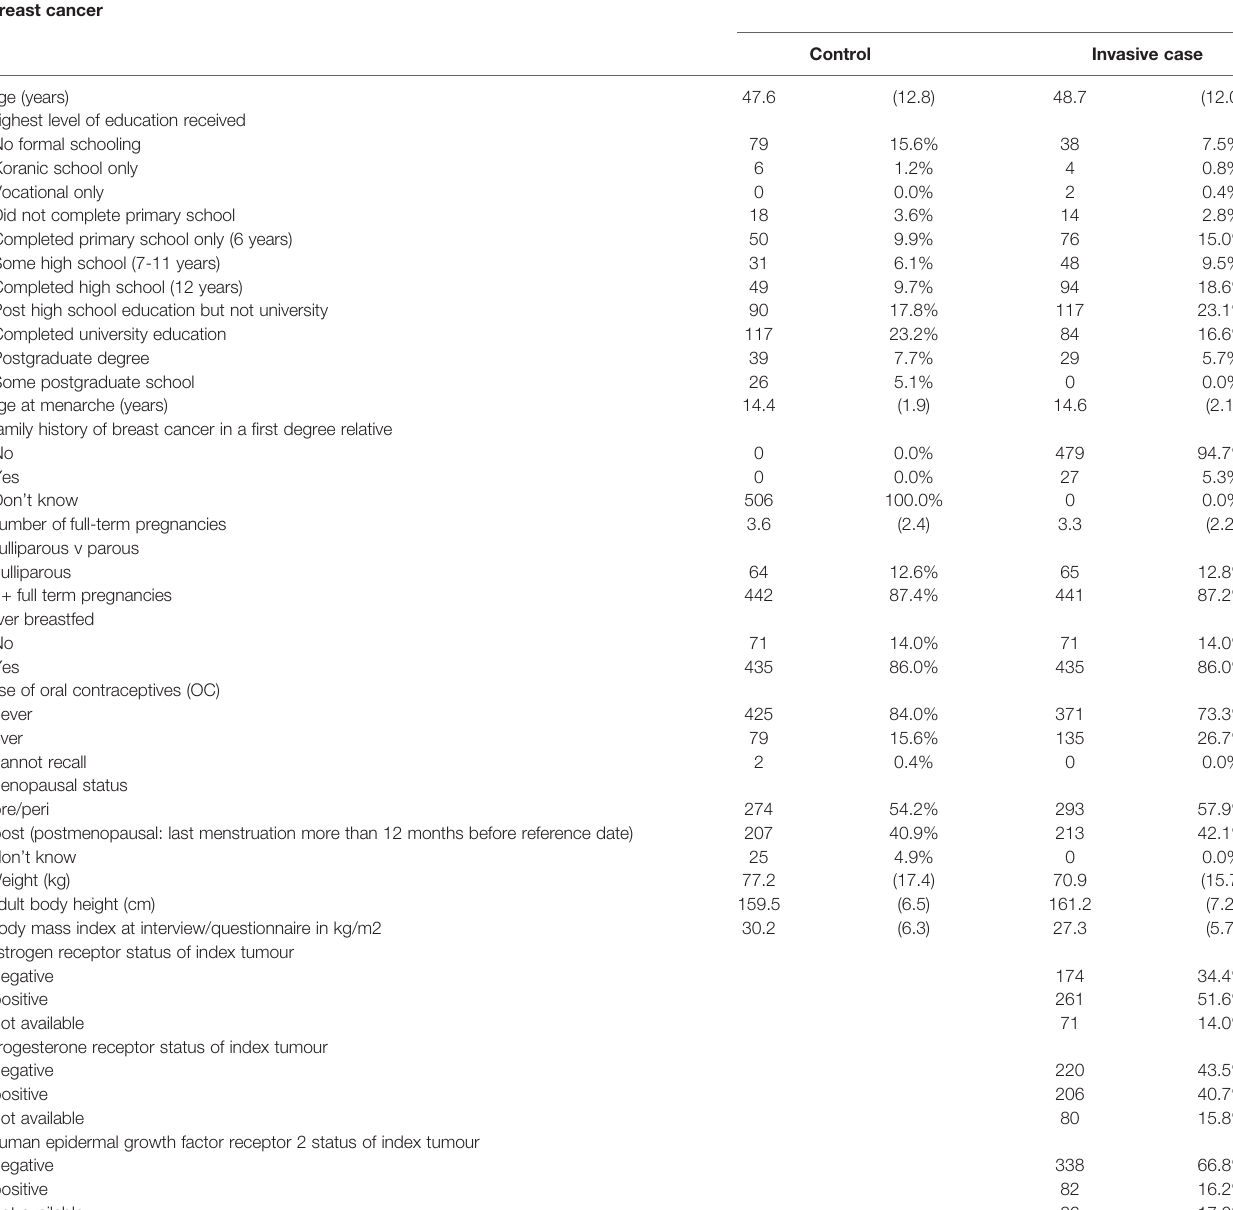
TABLE 2 | Baseline characteristics of participants in the AFBRECANE project in Nigeria, 2020. Breast